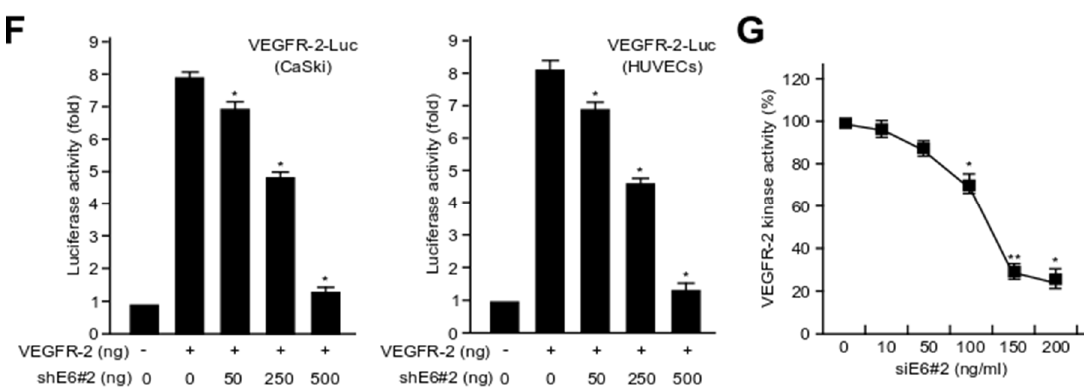
Figure 3. HPV16 E6 directly interacts with VEGFR-2, but not VEGFR-1. ( A ) Positive interactions were validated by determining the cell growth on a medium lacking leucine (upper panel) and by the formation of blue colonies (lower panel). β -galactosidase activity (unit), calculated by adding O -nitrophenyl β - D -galactopyranoside (ONPG) reagent, is shown below the corresponding lanes. All experiments were repeated at least three times with similar results. ( B ) Co-immunoprecipitation (Co-IP) of HPV16 E6 with VEGFR-1 or VEGFR-2. Immunoprecipitation (IP) of transfected cells was conducted using anti-Flag antibodies in total lysates, followed by immunoblotting with anti-HPV16 E6, anti-VEGFR-1 and anti-VEGFR-2 antibodies; (left panel) lane 1, pcDNA3.1 (empty-inserted expression vector only) and pcDNA3.1 / Flag-HPV16 E6 transfectant; lane 2, pcDNA3.1 / Flag-HPV16 E6, and pcDNA3.1 / VEGFR-1 transfectant; (right panel) lane 1, pcDNA3.1 (empty expression vector only) and pcDNA3.1 / Flag-HPV16 E6 transfectant; lane 2, pcDNA3.1 / Flag-HPV16 E6 and pcDNA3.1 / VEGFR-2 transfectant. ( C ) Endogenous proteins in whole cell lysates of human embryonic kidney 293T (HEK293T) cells were introduced into Co-IP with an antibody as indicated, followed by immunoblotting with an anti-HPV16 E6 or anti-VEGFR-2 antibody. Rabbit immunoglobulin G (IgG) and VEGFR-1 served as an IP-negative control. Input (non-IP) immunoblotting data indicated the integrity of cell lysates used for IP. All experiments were repeated at least three times with similar results. ( D ) HUVECs were treated with VEGF and then control-transfected or transfected with HPV16 E6 or HPV16 E6 plus HPV16 E6-siRNA (siE6#2). Phosphorylation of VEGFR-2 (Tyr-1175) was demonstrated using the specific antibody. The VEGFR-2 band ensured equal loading of samples. All experiments were conducted at least three times with consistent and similar results. ( E ) Cells were incubated with 10 ng/mL VEGF, and then incubated with either siScramble-transfected or transfected with HPV16 E6 or HPV16 E6 plus HPV16 E6-siRNA (siE6#2). Expression levels of VEGF and HIF-1 α protein were determined via immunoblotting analysis. All experiments were repeated at least three times with similar results. ( F ) Inhibitory effect of VEGFR-2-dependent transcription by HPV16 E6- siRNA (siE6#2). CaSki cervical cells and HUVECs were co-transfected with 500 ng of VEGFR-2-Luc, 500 ng of a VEGFR-2 expression plasmid (pcDNA3.1/VEGFR-2) and increasing concentrations of plasmid-encoding shE6#2 (pcDNA3.1/Flag-siE6#2) (50, 250 and 500 ng). Experiments were conducted in triplicate, and error bars show the mean ± SD; * p < 0.05 compared with control. ( G ) Suppression of VEGFR-2 kinase activity of HPV16 E6-siRNA (siE6#2) was analysed using an in vitro HTScan VEGFR- 2 kinase assay kit combined with colourimetric detection according to the supplier’s instructions. Data